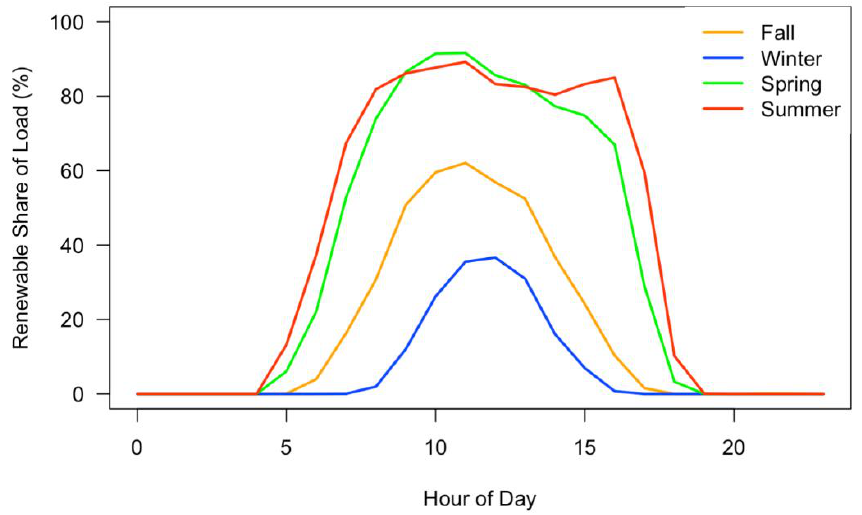
Figure 3. Amount of load met by solar and storage in each hour of the year. Only 7% of load was met by the renewable energy system in the winter months, and the rest was provided by community microgrid purchases. In the summer months, 38% of load was met by solar plus